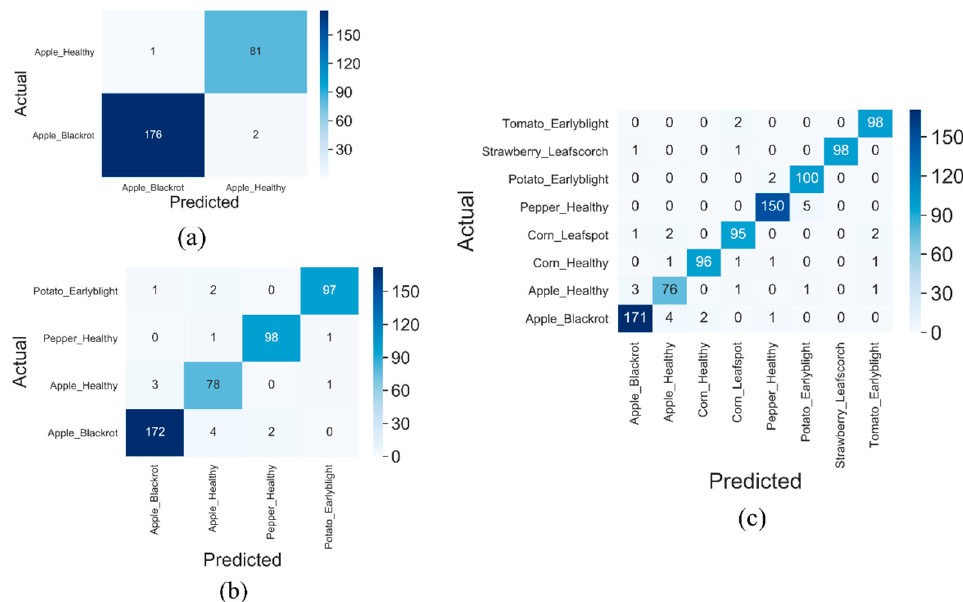
Figure 11. Confusion matrices for two, four, and eight class datasets. Confusion matrices obtained from fine-tuned ( a ) DenseNet121, ( b ) InceptionV3, and ( c ) DenseNet121 models for datase1b, dataset2b, and dataset3b, respectively.